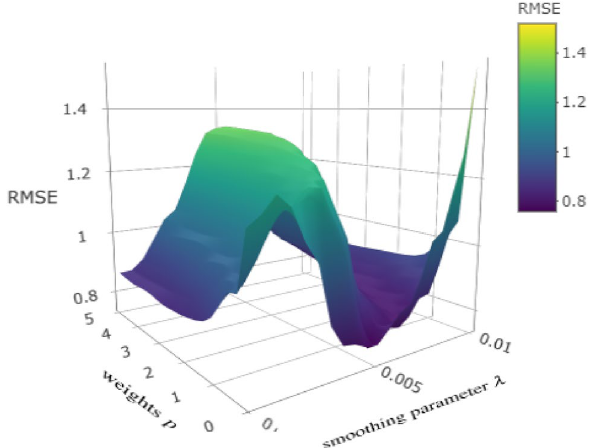
Figure 1. The model performance defined by RMSE of S. aureus with different levels of weights p on x-axis and smoothing parameter (cid:31) on y-axis is